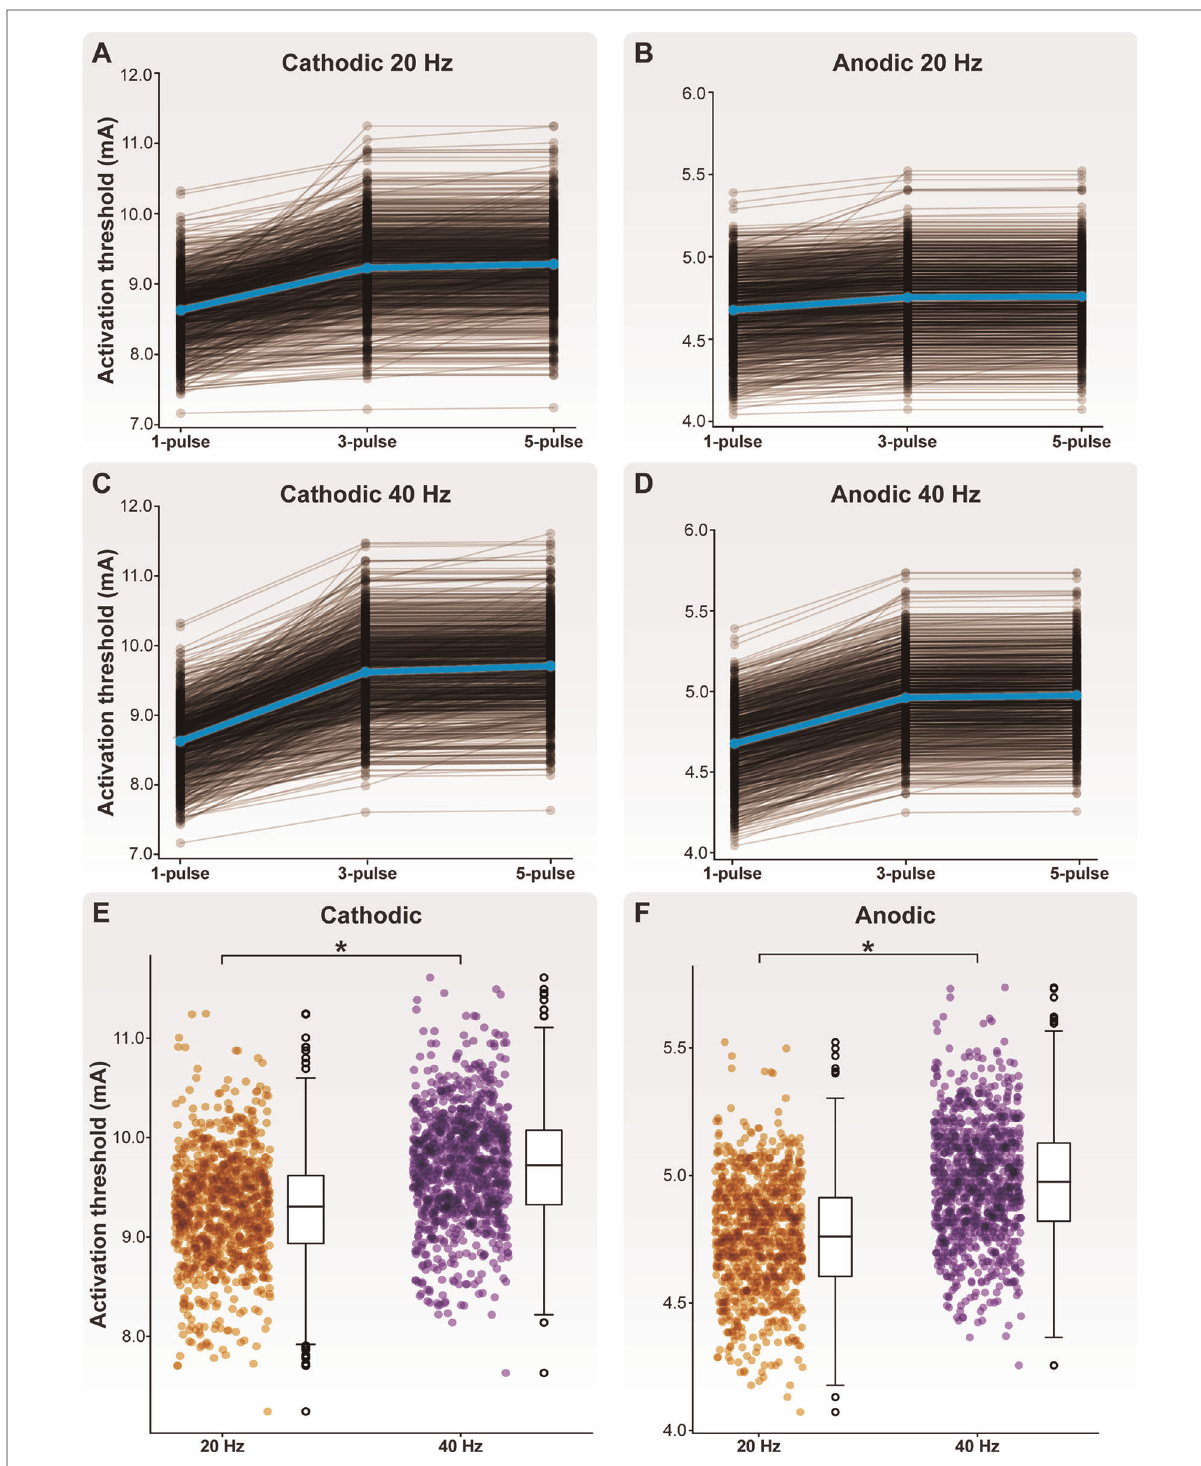
FIGURE 6 Activation thresholds of the model C-neuron population. Activation thresholds during ( A ) cathodic- fi rst DRGS applied at 20 Hz, ( B ) anodic- fi rst DRGS applied at 20 Hz, ( C ) cathodic- fi rst DRGS applied at 40 Hz, and ( D ) anodic- fi rst DRGS applied at 40 Hz. We calculated the threshold DRGS amplitude to produce one-to-one activation (i.e., every applied pulse generates at least one AP in a given cell) in response to one, three, and fi ve DRGS pulses. Each brown line corresponds to an individual model C-neuron, and each blue line corresponds to the model population average. Five-pulse activation thresholds in response to 40 Hz DRGS were signi fi cantly higher than activation thresholds in response to 20 Hz DRGS for both ( E ) cathodic- fi rst and ( F ) anodic- fi rst